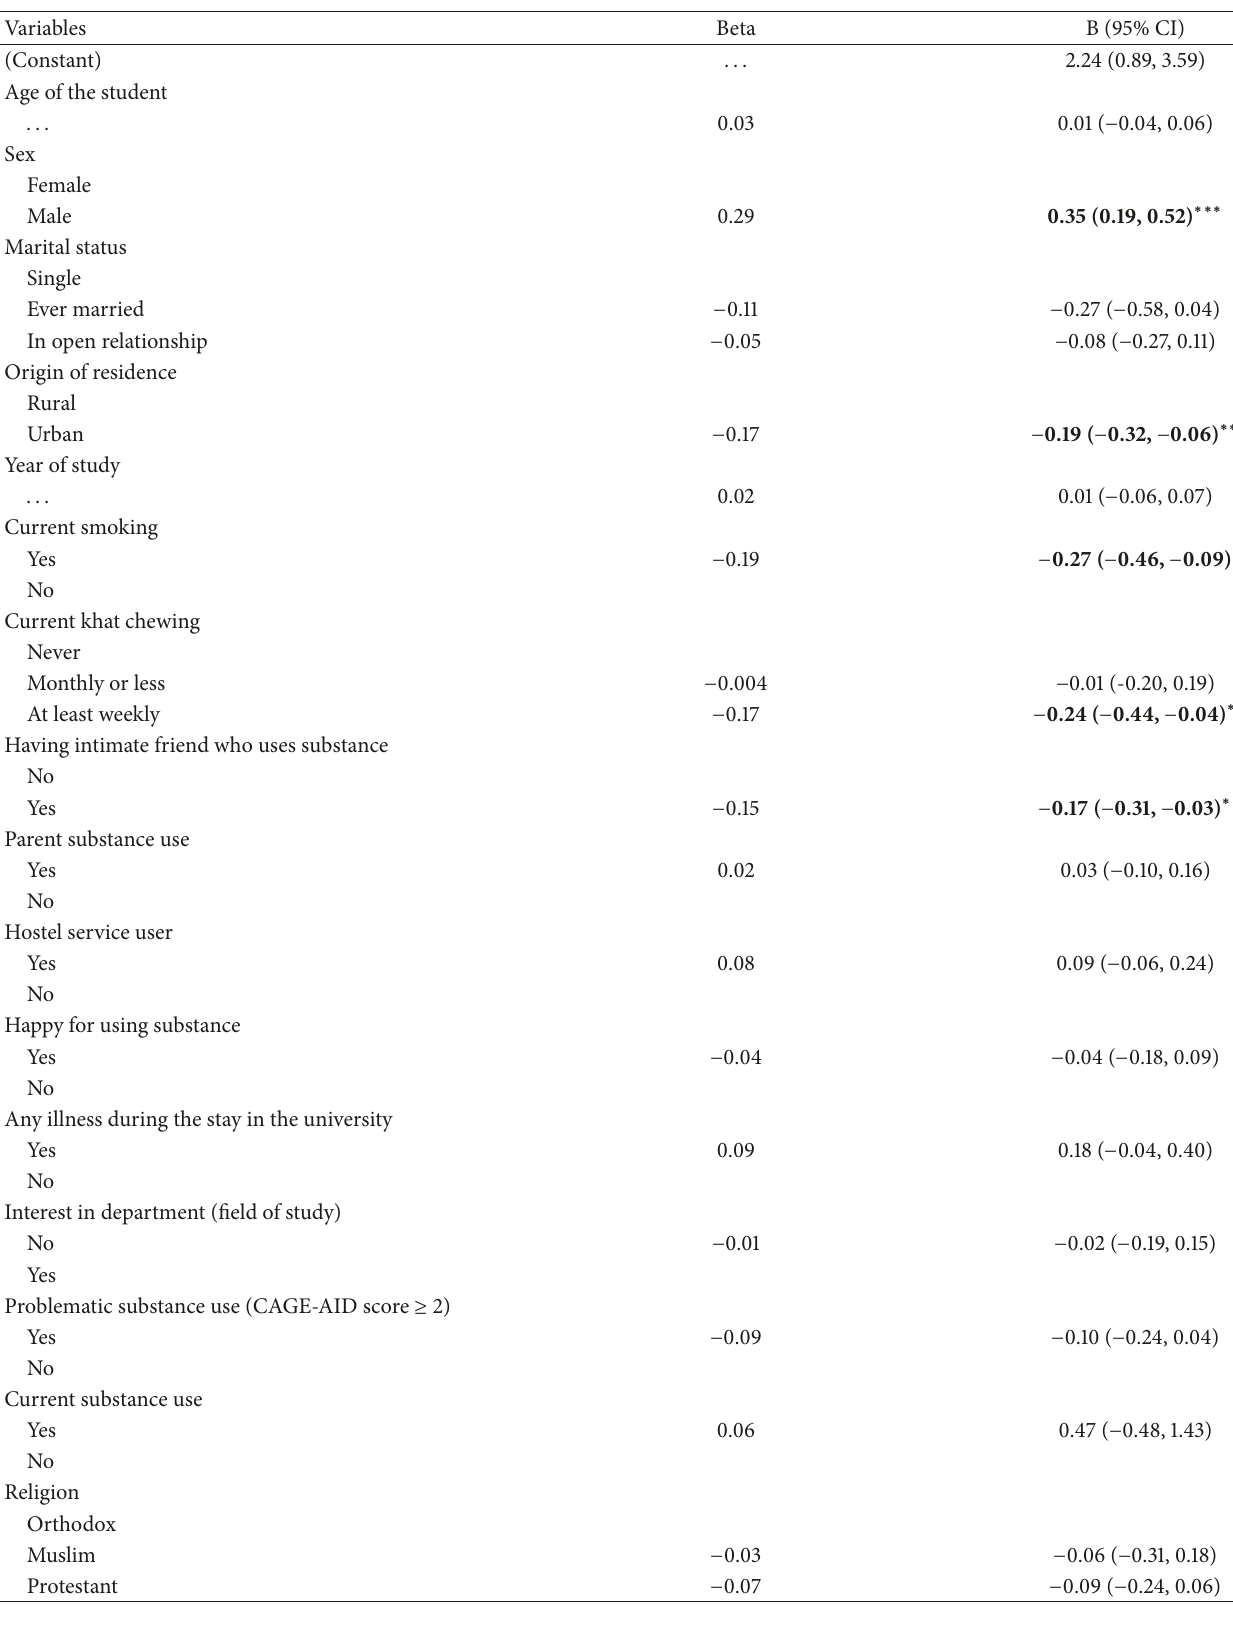
Table 5: Linear regression for substance use and academic performance among students,